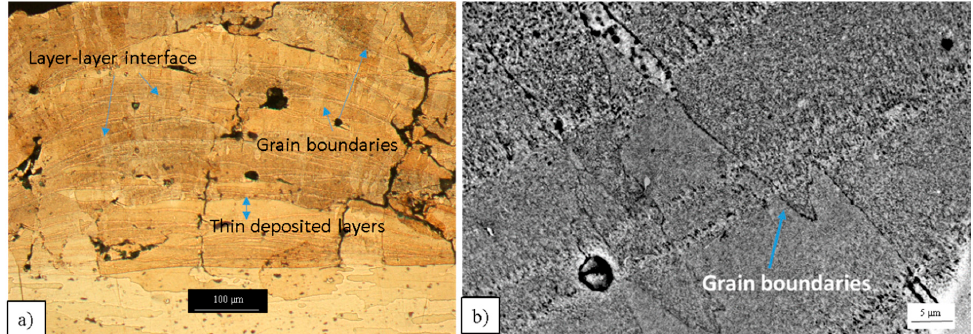
Figure 7. Overview of deposit cross-section: ( a ) Optical Microscope (OM) Nikon Epiphot image showing the microstructural of built-up layered deposit and ( b ) SEM micrograph showing the boundary of slender columnar like grain vertical to the build direction.